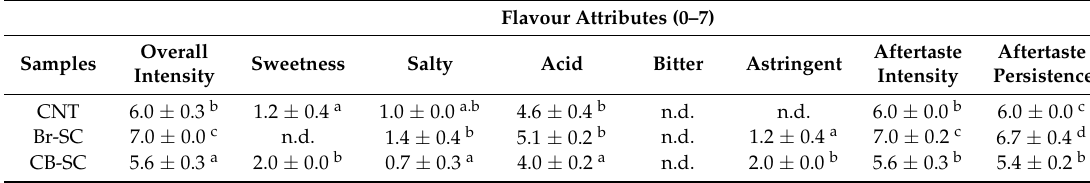
Table 3. Ratings for flavour attributes of seven spreadable cheeses investigated.